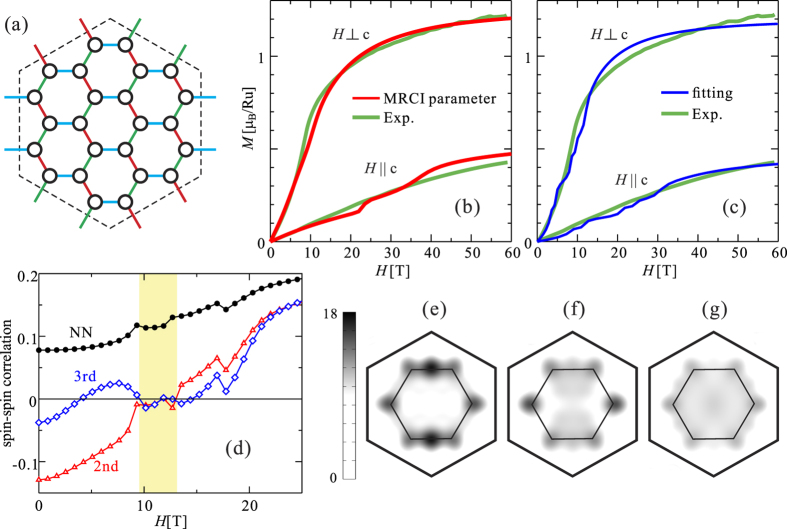
Magnetization curves and spin-structure factors for α-RuCl3.(a) 24-site cluster with PBC’s used in the ED calculations. (b) Experiment30 vs ED plots using MRCI g factors and NN couplings plus J2 = J3 = 0.25 meV. (c) ED magnetization curves with J = 1.0, K = −5.0, J2 = J3 = 0.3, gab = 2.4, gc = 0.95 and vanishing off-diagonal NN couplings. (d) Field dependence of the NN, second- and third-neighbor spin-spin correlation functions  extrapolated to the thermodynamic limit, using MRCI g factors and NN couplings, J2 = J3 = 0.25 meV and field along the c axis. Static spin-structure factors S(Q) are shown for (e) H = 0, (f) H = 9.5, (g) H = 10.5 T.